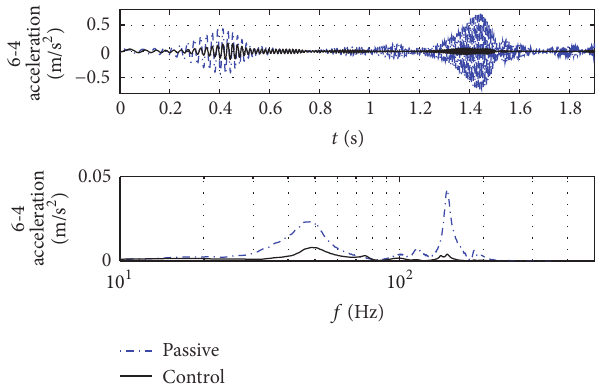
Figure 19: Comparison time-frequency domain curves of accelera- tion response of position 6-4 on the isolation system before and after being controlled under double linear swept sine interference.